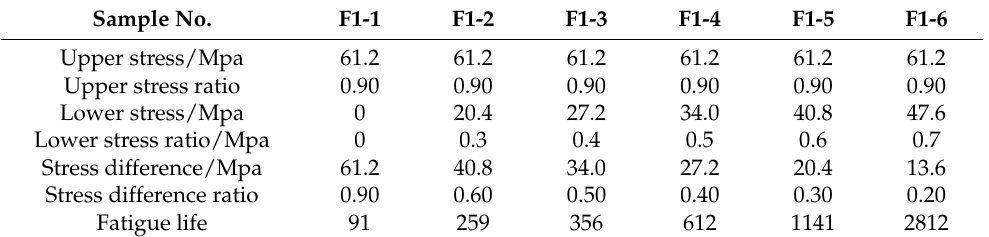
Table 1. The influence of lower limit stress on the fatigue life of yellow sandstone samples. Sample No.